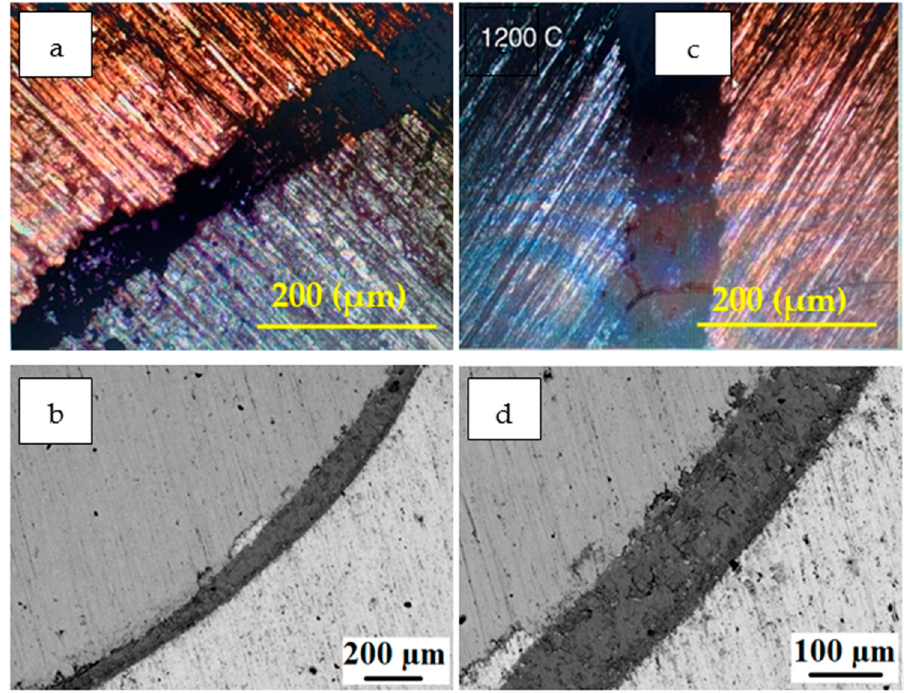
Figure 6. ( a ) Light microscopy image; ( b ) SEM image of a QMMC prepared at 800 °C; ( c ) and ( d ) are light microscopy and SEM images, respectively, of QMMC prepared at 1200 °C.